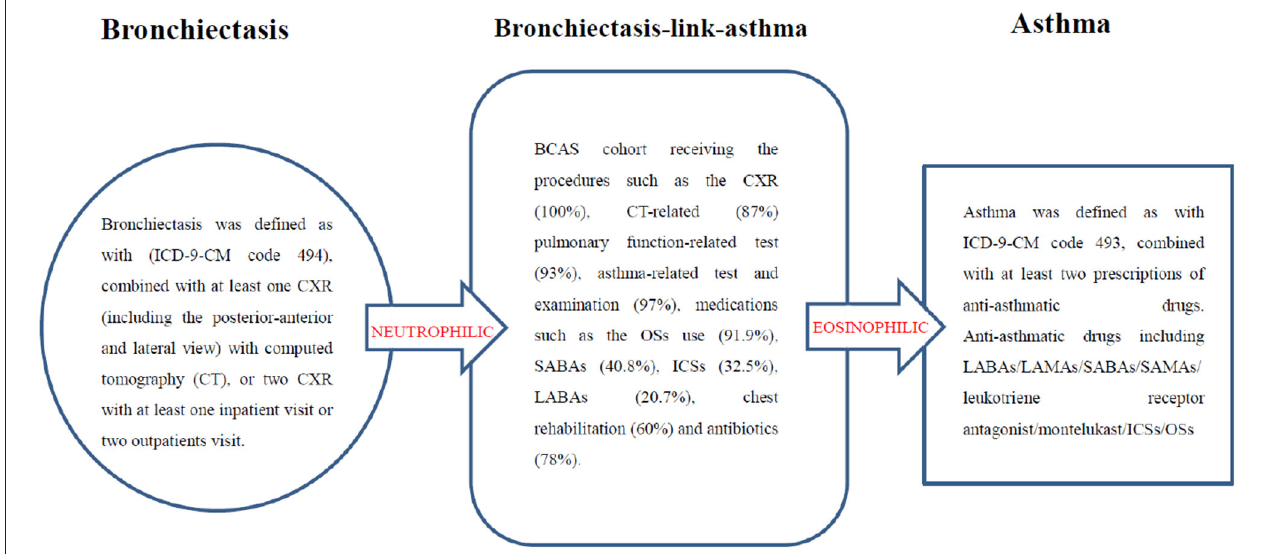
FIGURE 4 | Validation of bronchiectasis-asthma combination.